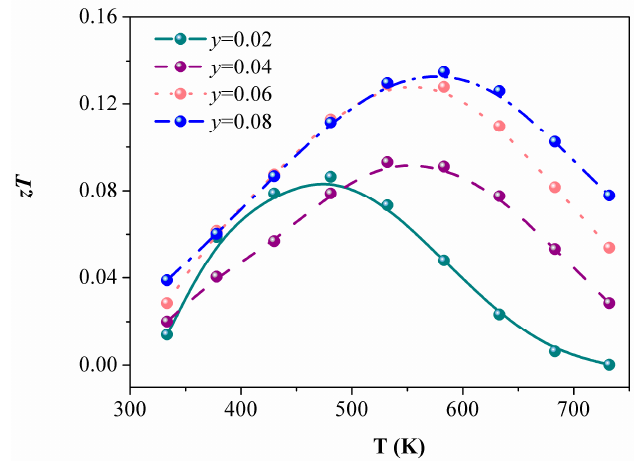
Figure 7. zT plots of Eu 5 − y La y In 2.2 Sb 6 ( y = 0.02, 0.04, 0.06, 0.08).